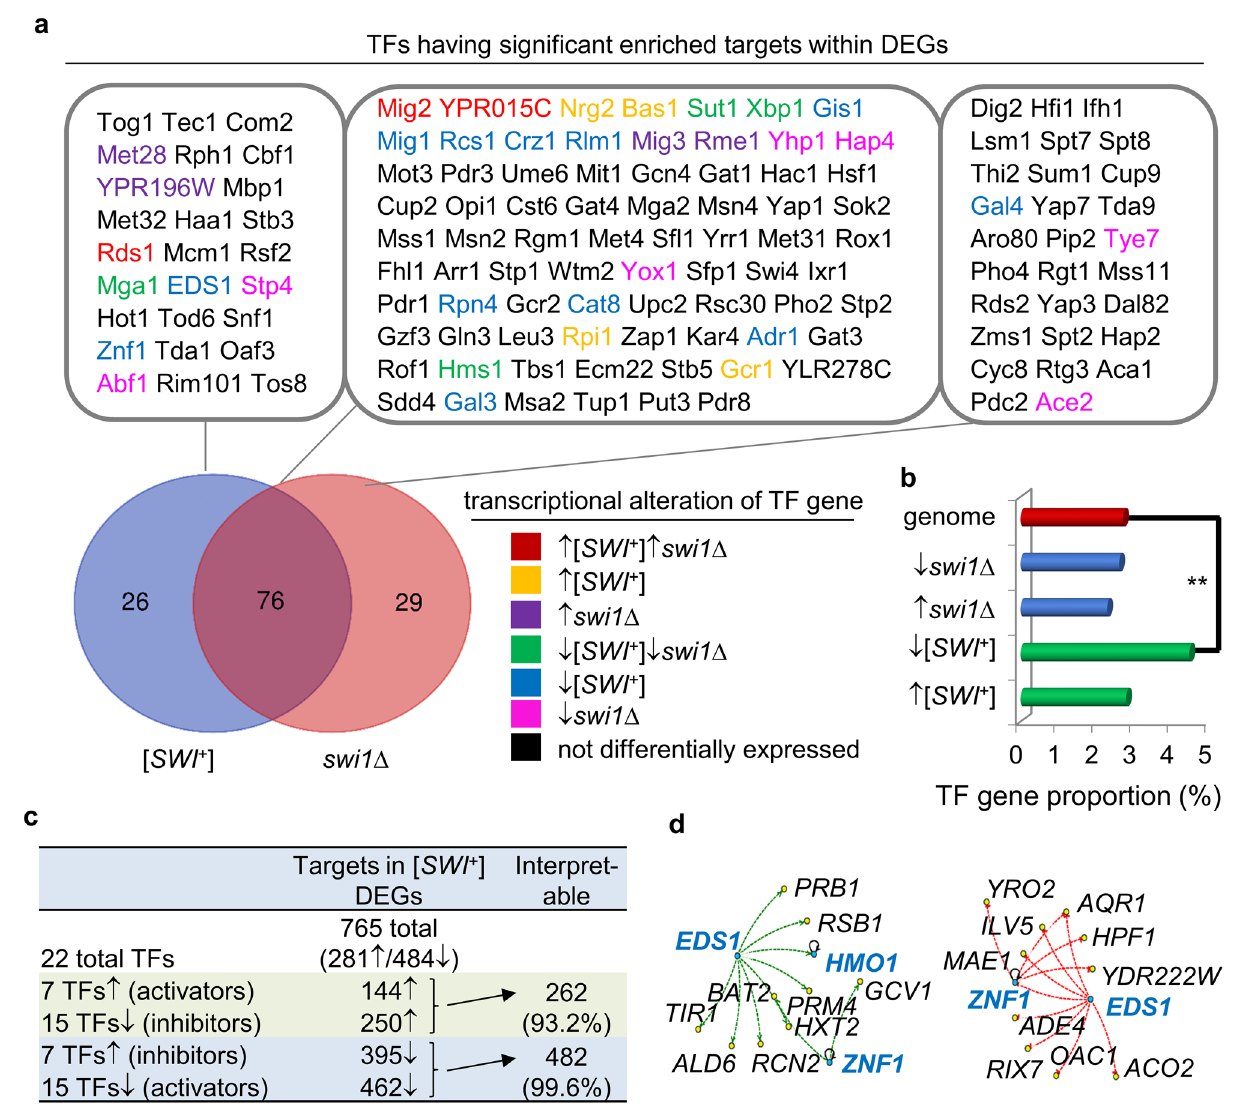
Figure 2. Contribution of altered transcription of TF genes to [ SWI + ] DEGs. ( a ) Shown are transcription factors (TFs) that have overrepresented regulatory targets within the DEGs in [ SWI + ] and swi1∆ cells (genes listed in the order of p-value, small to large). TF genes that are regulated similarly or differently by [ SWI + ] and swi1∆ are indicated by different colors, and the overlay of these TFs of [ SWI + ] and swi1∆ are also shown. ( b ) Proportion of upregulated and downregulated TF genes among DEGs in [ SWI + ] and swi1∆ cells. The analysis was based on 183 consensus TF genes defined by YEASTRACT. Significance was calculated using Fisher’s Exact Test that gave a p-value of 0.006. ( c ) 22 TFs with altered transcription in [ SWI + ] cells and with overrepresented targets among the prion DEGs (p-value < 0.001 using YEASTRACT, total 765 collective target DEGs). The upregulation of ~ 93.2% (262 combined unique genes out of the 281 total) DEG targets, and the downregulation of ~ 99.6% (482 unique genes out of the 484 total) are interpreted by a combined effect of the transcriptional alterations (up-or down-regulation) and regulatory activities (as inhibitors or activators) of the TFs. The TF/ targets associations were defined based on published genetic data according to YEASTRACT. ( d ) Regulatory networks of two overrepresented transcription factors (Znf1 and Eds1) that are downregulated specifically in [ SWI + ] cells. Left, DEGs/targets inhibited in [ SWI + ] cells when Znf1 and Eds1 function as activators; and right, DEGs/targets activated in [ SWI + ] cells when they function as inhibitors. All TFs are in transcription of 126 DEGs and the reduced transcription of another 196 DEGs in swi1∆ cells when these TFs function as activators and inhibitors, respectively. Similarly, the decreased transcription of the 8 TF genes can be used to explain the downregulation of 323 DEGs and the upregulation of 140 DEGs in swi1∆ cells when they act as activators and inhibitors, respectively. Taken together, the altered transcription of these 12 TF genes may be responsible for the increased transcription of 140 DEGs (47.0% out of the 298 upregulated DEG targets) and the reduced transcription of 398 DEGs (70.0% out of the 569 downregulated DEG targets) in swi1∆ cells (Table S2).